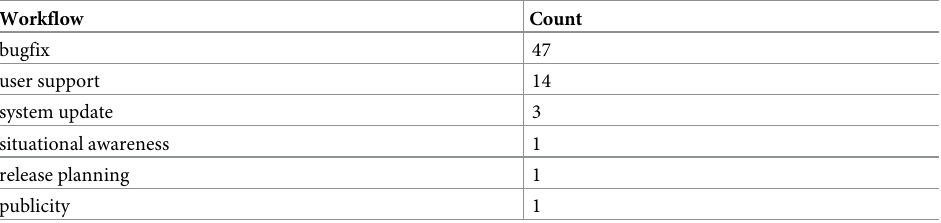
Table 7. Workflow labels and incidence. Note that they do not sum to 65 since two workflow instances overlap as the “bugfix” and “user support”